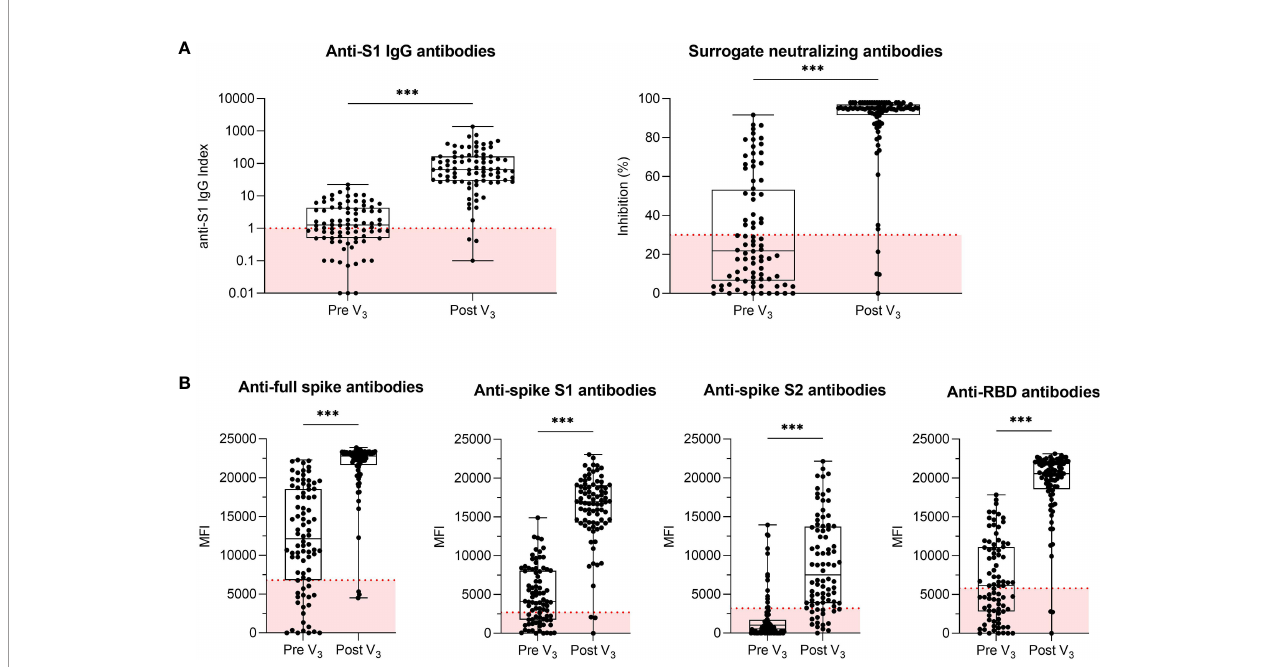
FIGURE 2 | Humoral response in hemodialysis patients before and after a third BNT162b2 vaccine dose. (A) Anti-S1 IgG and surrogate neutralizing antibodies in 84 hemodialysis patients before and after a third BNT162b2 vaccine dose. An anti-S1 IgG index ≥ 1 and an inhibition ≥ 30% as indicated by the dashed red line de fi ned seroconversion for anti-S1 IgG and surrogate neutralizing antibodies, respectively. (B) IgG antibodies against SARS-CoV-2 full spike, spike S1, spike S2 and receptor-binding domain (RBD) as determined by a bead-based multiplex assay. The y-axis represents the mean fl uorescence intensity (MFI) with a red dashed line indicating the cut-off for each respective target. Anti-RBD antibodies were chosen to de fi ne the seroconverted cohort for later live virus neutralization as the RBD of the SARS-CoV-2 spike protein is a major target of neutralizing antibodies that block viral attachment to the host cell. MFI, mean fl uorescence intensity; RBD, receptor-binding domain; V, vaccination; *** P <